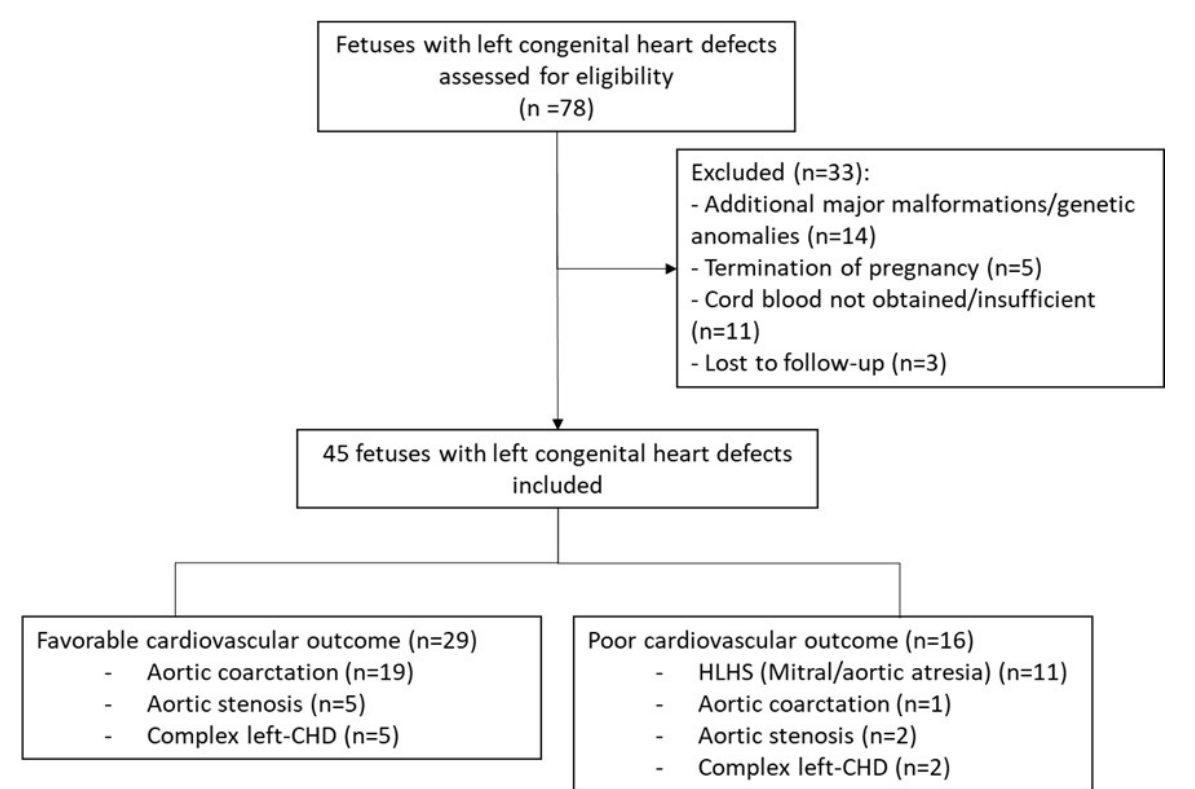
Figure 1. Flowchart of fetuses with left-side congenital heart defects included in the study. Maternal baseline characteristics, standard obstetrical ultrasound results, and peri- natal results are shown in Table 1. The three study populations were similar in terms of maternal characteristics, gestational age at scan, estimated fetal weight, and centile and fetal Doppler. The mean uterine artery pulsatility index was more frequently abnormal (>95th centile) in the favorable cardiac outcome left-CHD group as compared to the normal heart group. Gestational age at delivery was similar across groups, and only two fetuses were born prematurely (one control and one favorable cardiac outcome left-CHD). Cesarean section was more frequent in the poor cardiac outcome group. Prevalence of pregnancy complications was similar in the three groups, including gestational diabetes, preeclampsia, birthweight < 3rd centile, and macrosomia. Birthweight, Apgar score, and umbilical artery pH were also similar. Table 1. Maternal baseline characteristics, standard ultrasound, and perinatal results in the study